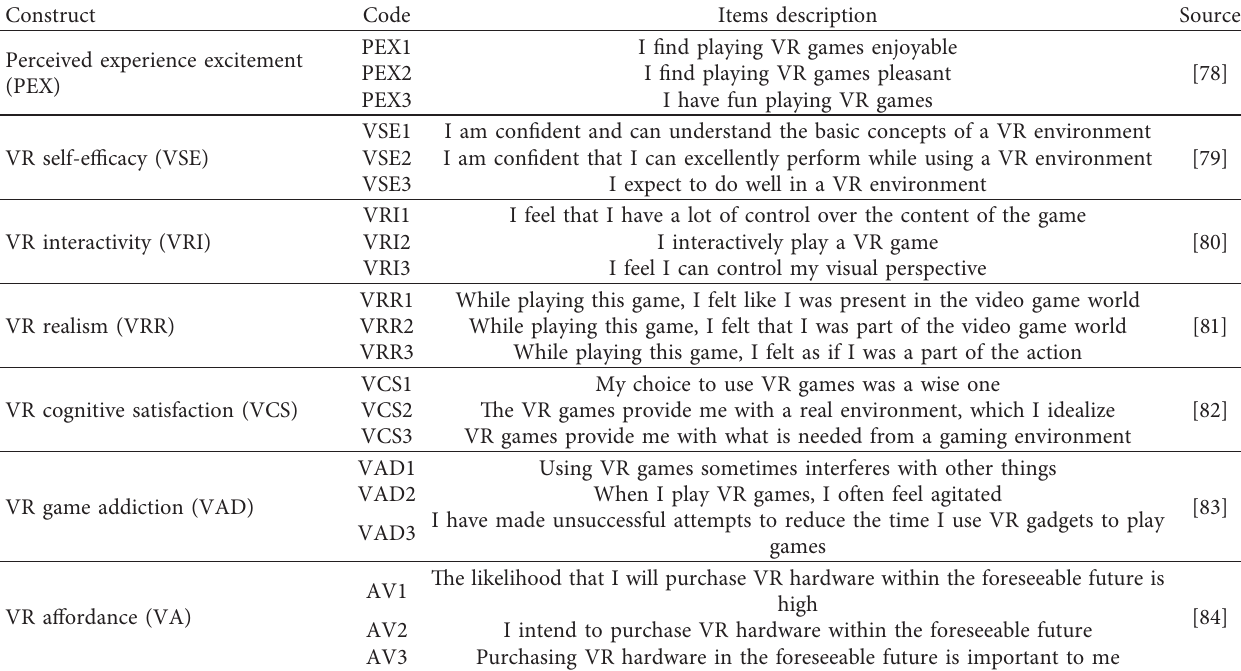
Table 2: Constructs, instruments, and